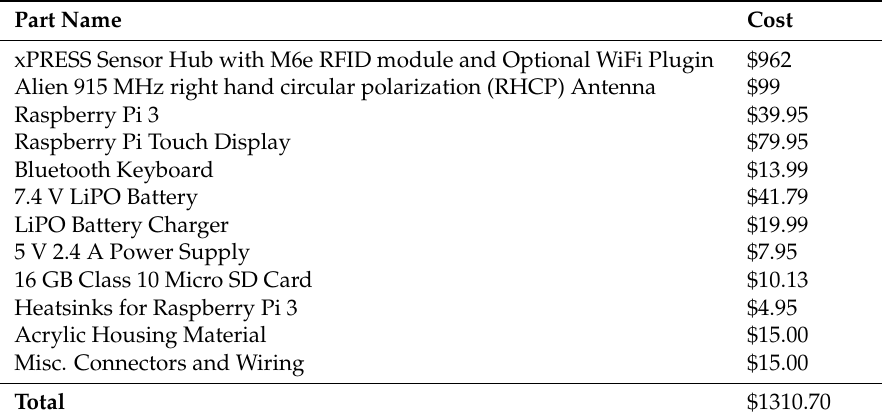
Table 1. Inclusive bill of materials for all materials used to construct the prototype